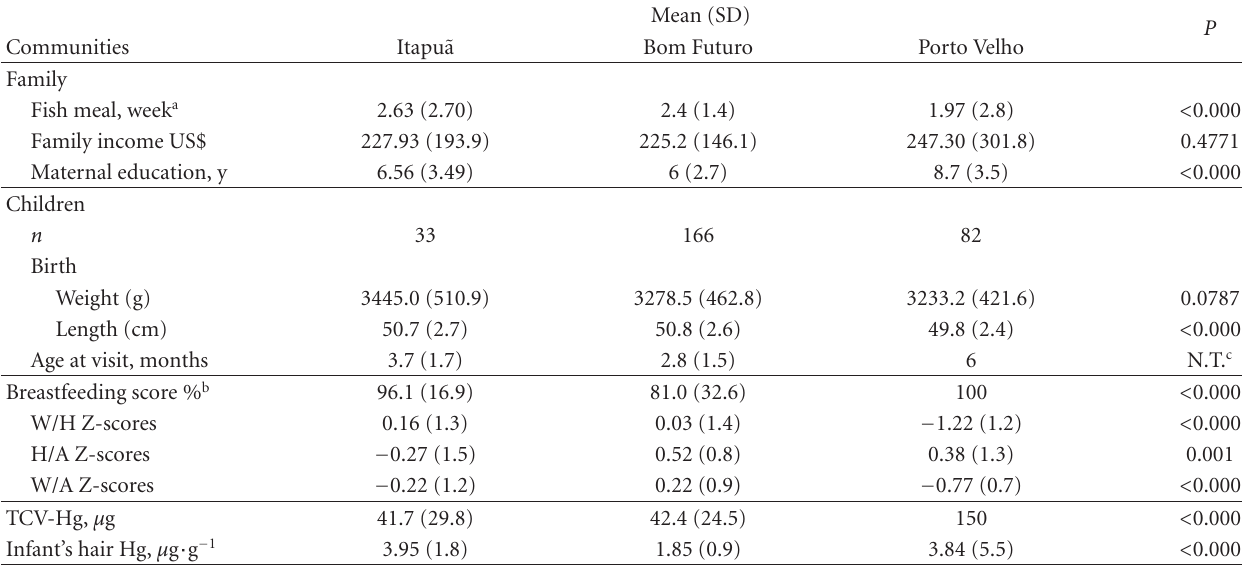
Table 1: General characteristics of families and respective infants in the study.